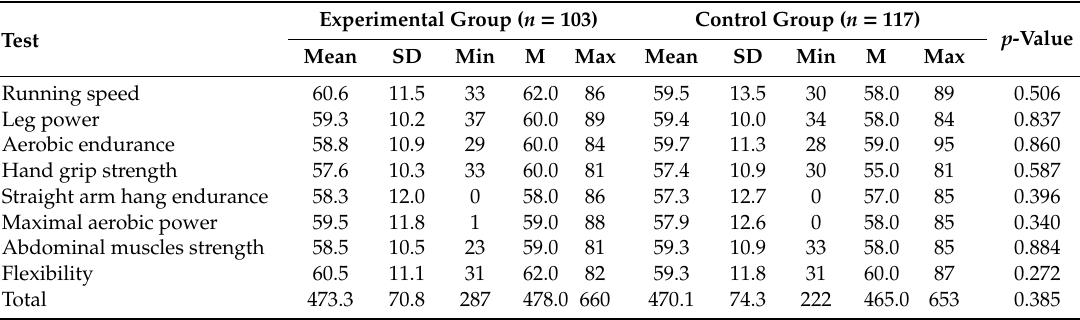
Table 3. Comparison of physical fitness of the students in the experimental group and the control group in the initial measurement.